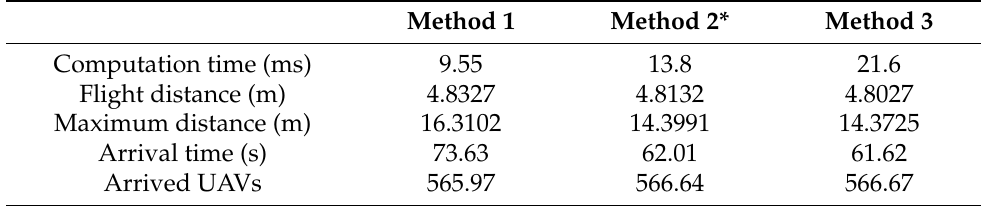
Table 3. Comparison of simulation results of the formation transformation of 600 UAVs using three